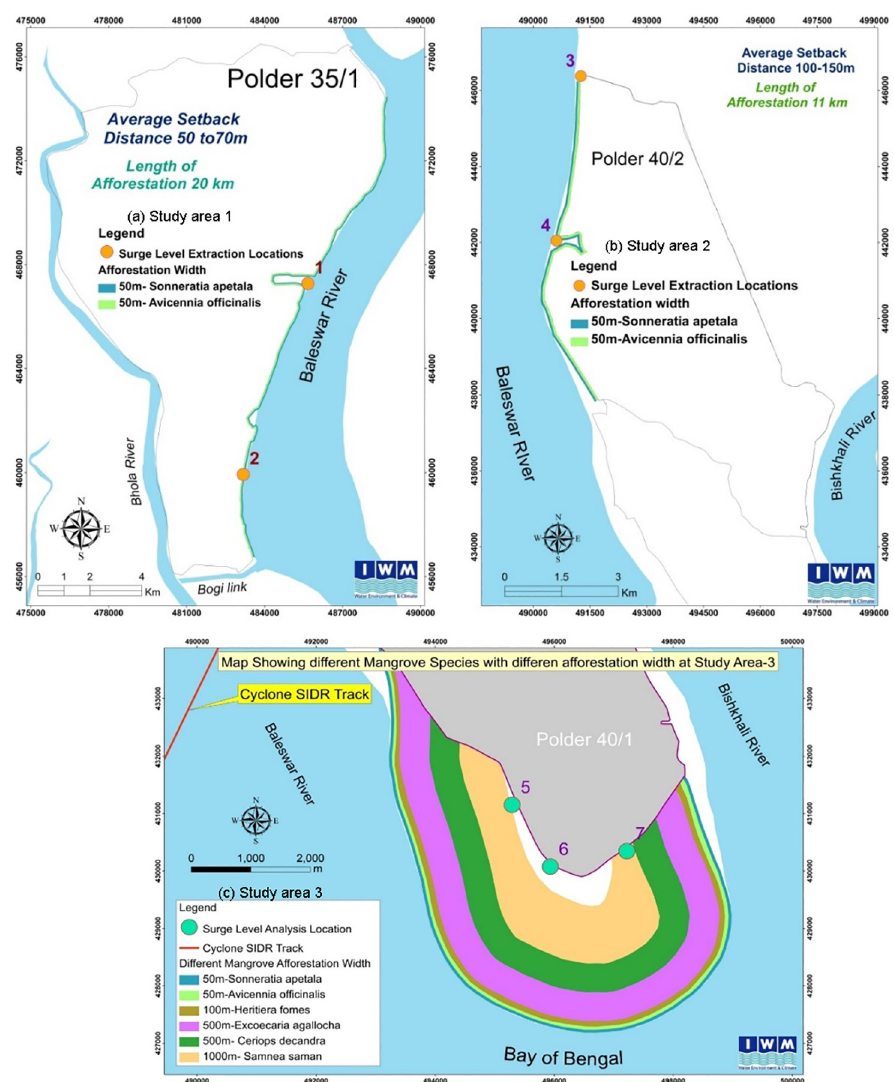
Fig 2. Afforestation area for analysis. (a) Study area 1, (b) Study area 2, (c) Study area 3. Among the selected species for this analysis, irrespective of water depth, S . apetala causes maximum obstruction, followed by A . officinalis and H . fomes . Estimates further indicate that resistance of E . agallocha exceeds that of C . decandra for all water depths considered in our analysis. For example, at 5 m water depth, the Manning’s coefficient for S . apetala is 8.91, fol- lowed by H . fomes (9.79), A . officinalis (9.86), E . agallocha (11.59), and C . decandra (11.94). As expected, resistance to water flow also increases with planting density. For example, for S . ape- tala at 5 m water depth, the Manning’s coefficients are 12.98, 11.42, and 8.91 at respective spac- ings of 10 m, 7.5 m and 5 m. However, planting density or minimum spacing between trees depends on the trunk/branch structures of the mangrove species. Field observations consider- ing minimum distance between mature trees conclude that planting of S . apetala at 5 m spac- ing, A . officinalis at 4 m spacing, and H . fomes , E . agallocha , and C . decandra at 5 m spacing in